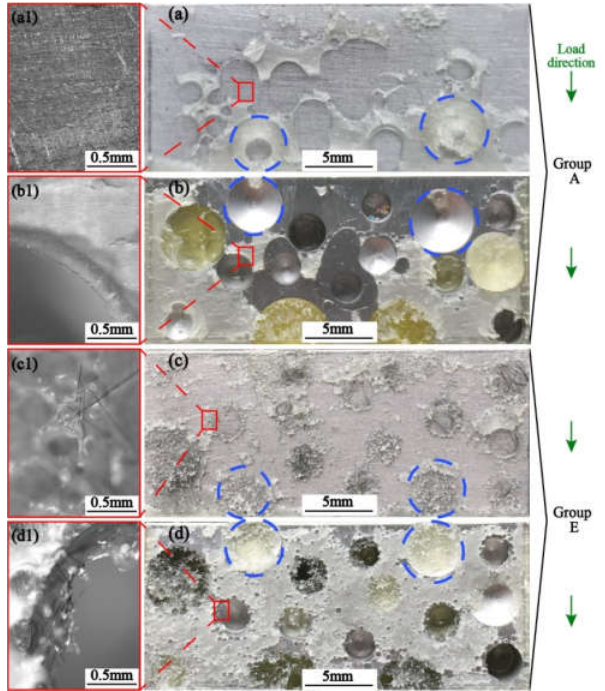
Figure 14. Fracture surfaces of unreinforced SLJ (Group A, pure adhesive) with ( a ) panel, ( b ) the perforated aluminum block and reinforced SLJ (Group E, 0.2%wt & 3 mm CF) with ( c )panel, ( d )the perforated aluminum block